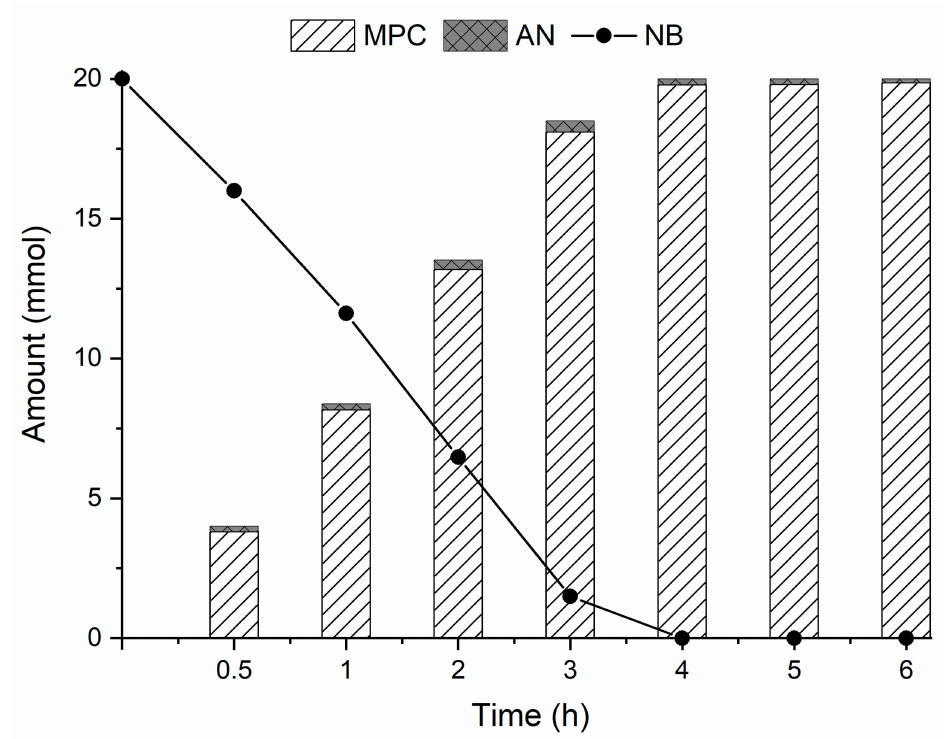
Figure 3. Product compositional changes as a function of time in the reductive carbonylation of NB at 160 ◦ C, 8.3 MPa of CO in the presence of 1 g of 5 wt% FeSe 2 / γ -Al 2 O 3 . Conditions: NB (20 mmol), 5 wt% FeSe 2 / γ -Al 2 O 3 (1 g, [FeSe 2 ]: 0.2338 mmol), molar ratio of NB / FeSe 2 = 85, MeOH (30 mL), T = 160 ◦ C, p = 8.3 MPa of